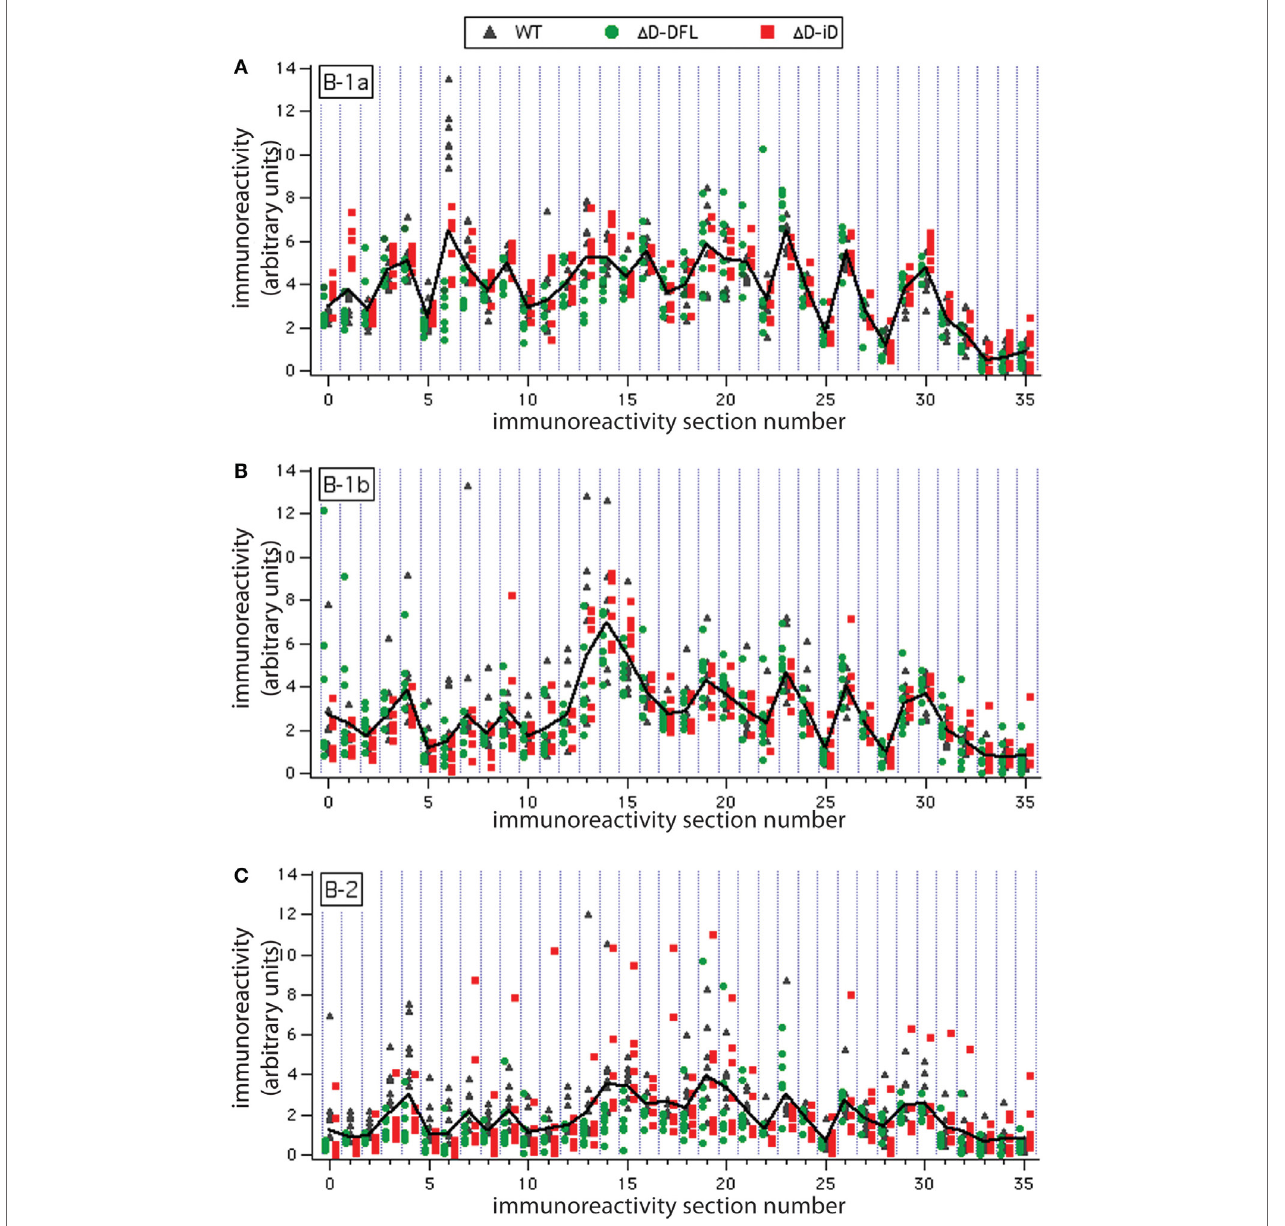
FigUre 4 | Variance distribution of reactivities around the mean densitometric profile for each Perc B cell subset . Supernatant magnitudes of reactivity against the 36 sections in which reactivity profiles divided are plotted in (a–c) . These corresponded to B-1a, B-1b, and B-2 subsets, respectively. Solid lines indicate the mean profile of all supernatants for each B cell